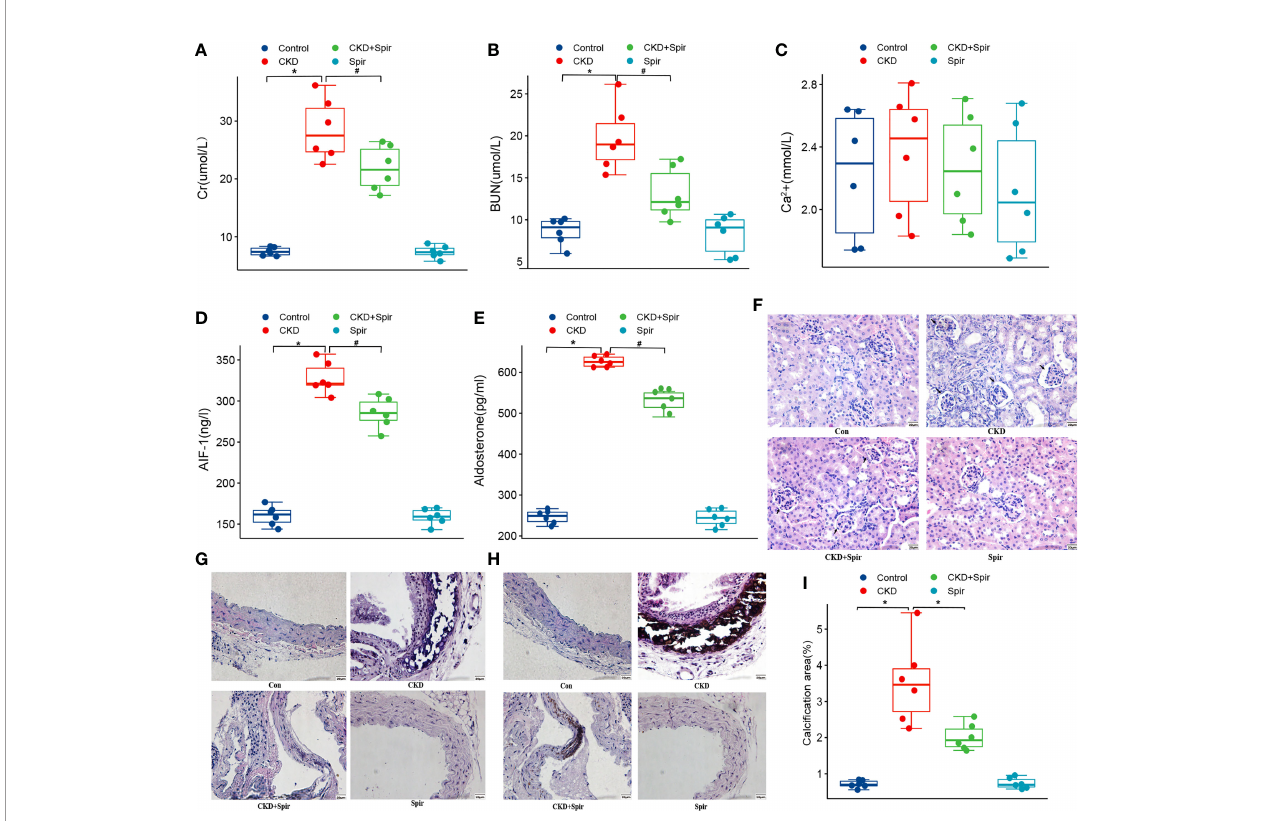
FIGURE 1 | The serum Cr, BUN, Ca 2+ , AIF-1, and Aldo levels in CKD mice model (A – E) . The histomorphology of renal tissue(400X) (F) and thoracic aorta(400X) (G) . VonKossa staining(400X) (H) and quantitative analysis (I) . (n=6) (*P<0.05, Control group vs. CKD group; # P<0.05, CKD group vs. CKD+Spir